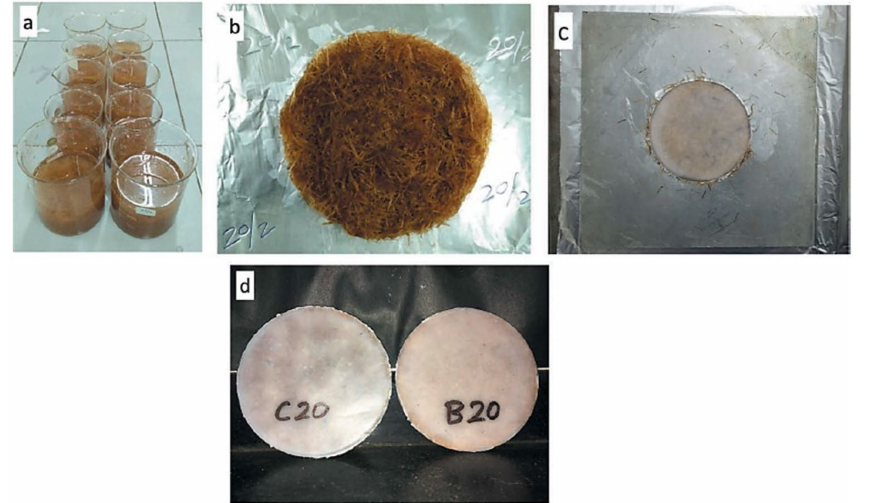
Figure 5. The process includes ( a ) fiber treatment followed by layering of fibers to form ( b ) fibrous bed, composite sample preparation through ( c ) compression molding, and ( d ) final composite samples. Reproduced with permission from Ref. [69]. Copyright 2021 Taylor &